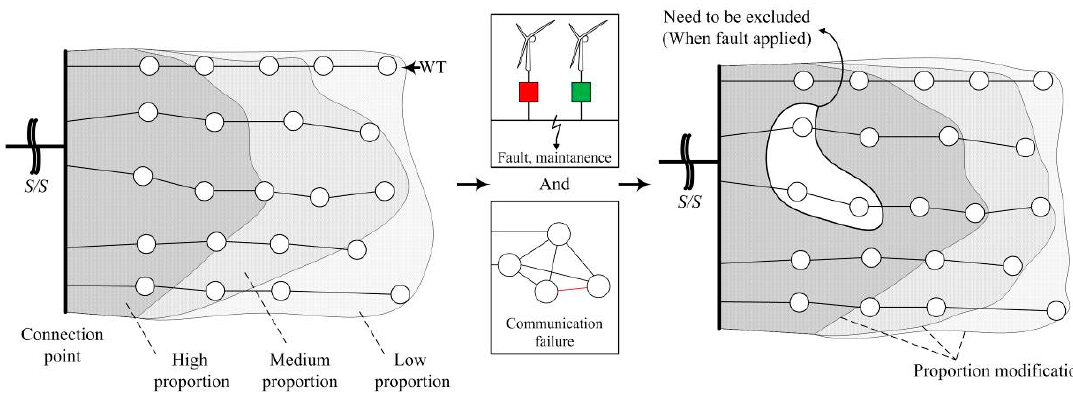
Figure 3. Schematic description for proposed plan.